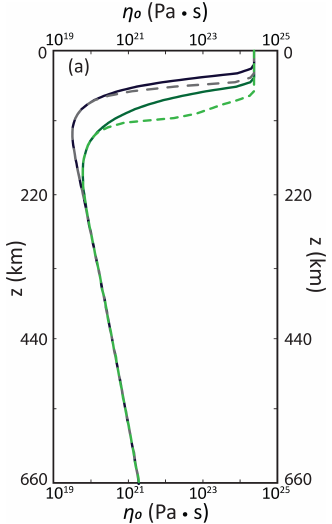
Figure B1. Viscosity profiles for cases with and without rheological stiffening. Solid lines correspond to cases without rheological stiff- ening, while dashed lines correspond to cases which include rheo- logical stiffening. In black and gray, profile at the oceanic side of the model; in dark and light green, profile at the continental side of the model. All the remaining properties as in the reference